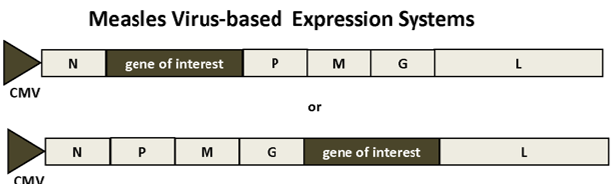
Figure 4. Rabies Virus-Based Expression Systems. The structural genes are from the HEP-Flury strain except the G protein from the CVS strain. Foreign genes can be inserted between the N and P or G and L genes, respectively. CMV, cytomegalovirus promoter; G, rabies G protein; L, rabies L protein; M, rabies matrix protein; N, rabies nucleocapsid protein.